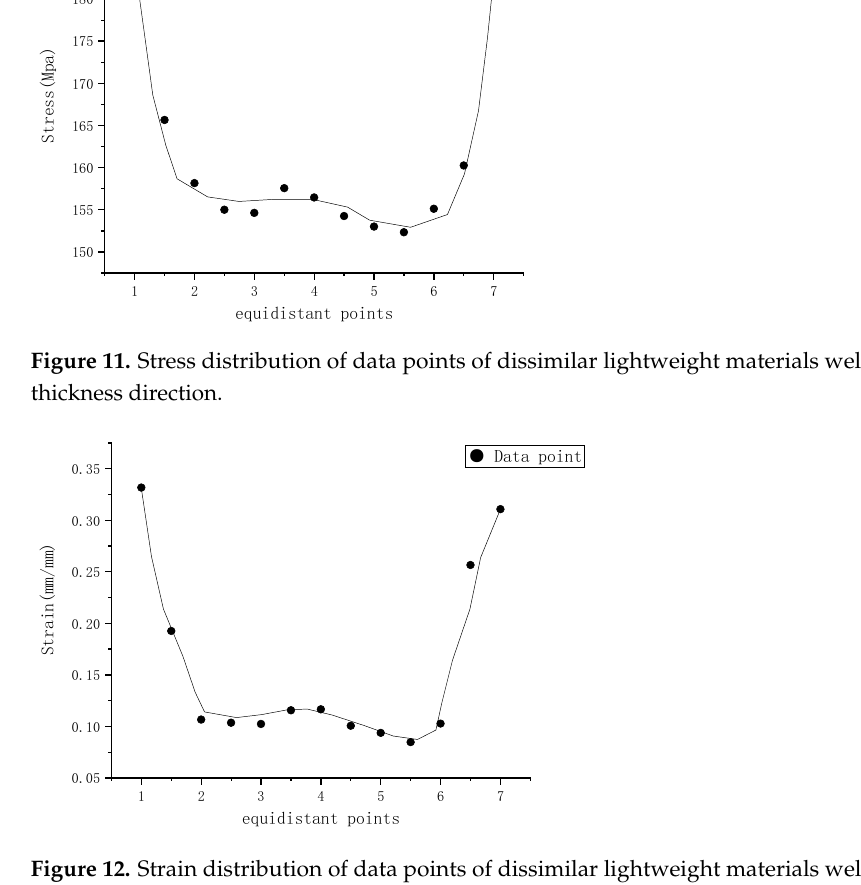
Figure 12. Strain distribution of data points of dissimilar lightweight materials welded joint along thickness direction.